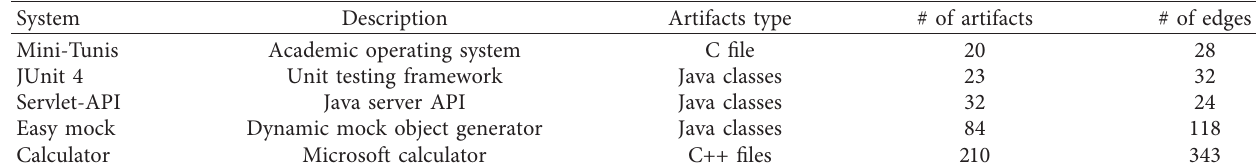
Table 3: Systems used in the case